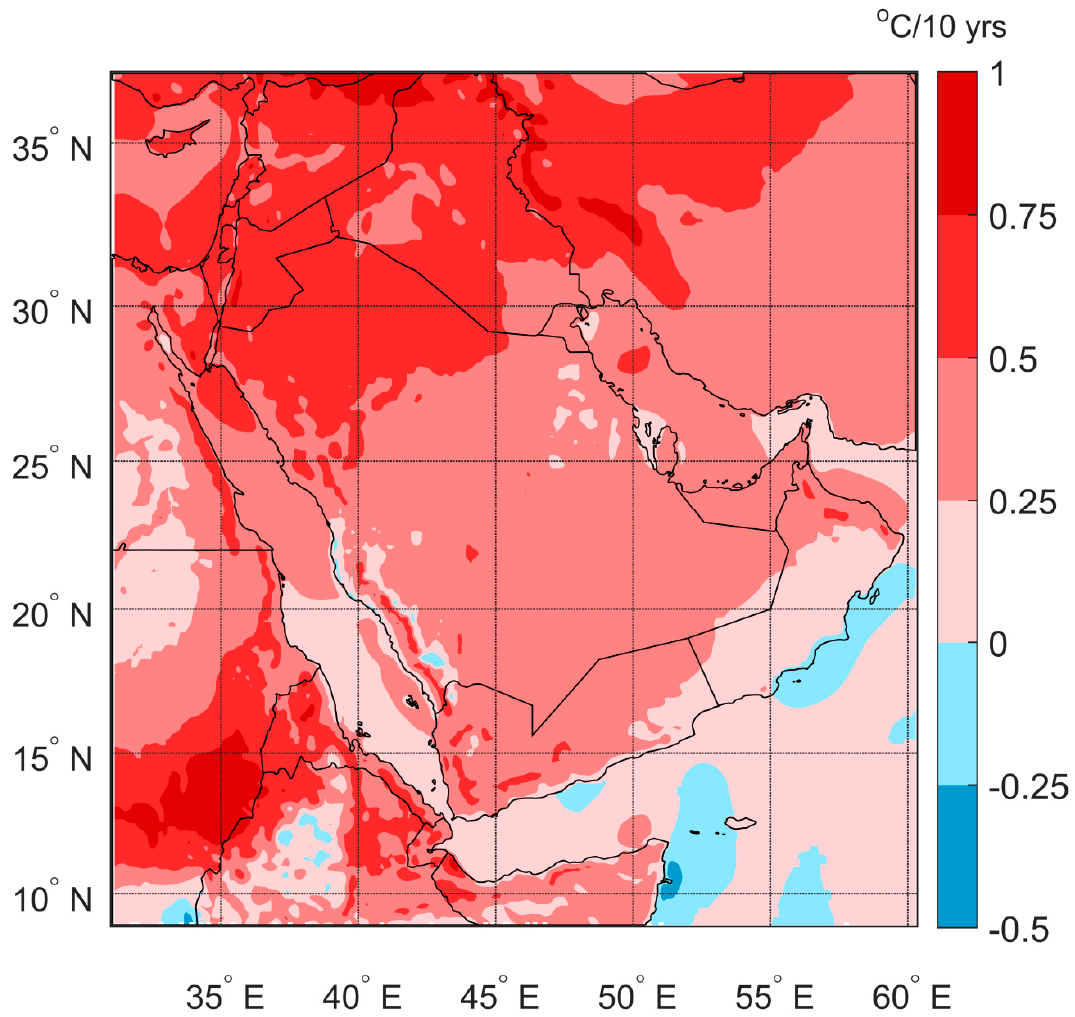
Figure 16. Daily maximum temperature change per 10 years (yrs).